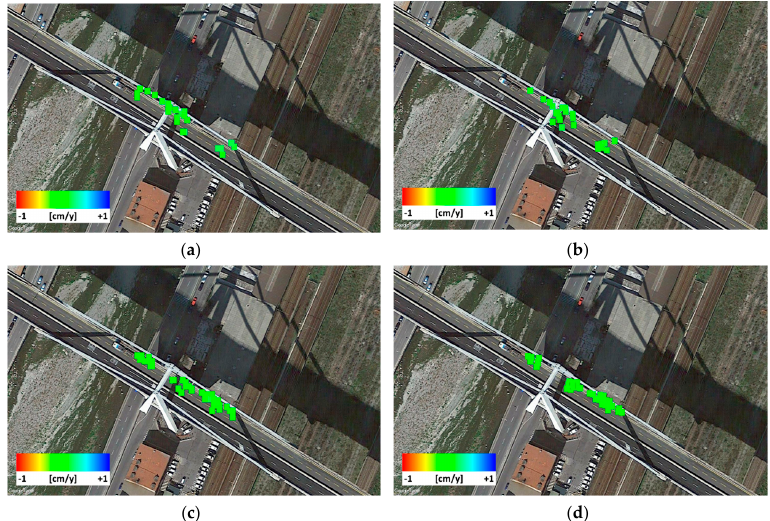
Figure 7. Zoom of Figure 4 in the area of interest related to the collapsed pillar, ( a ) SBAS and ( b ) TomoSAR processing results over the ascending dataset, and ( c ) SBAS and ( d ) TomoSAR results relevant to the descending dataset.